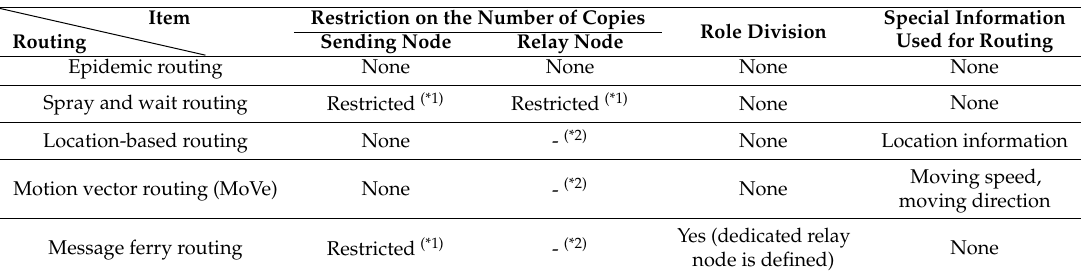
Table 1. Characteristics of the existing routing methods.